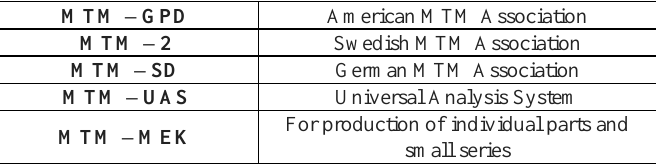
Table 2: Ramifications of MTM organizations.